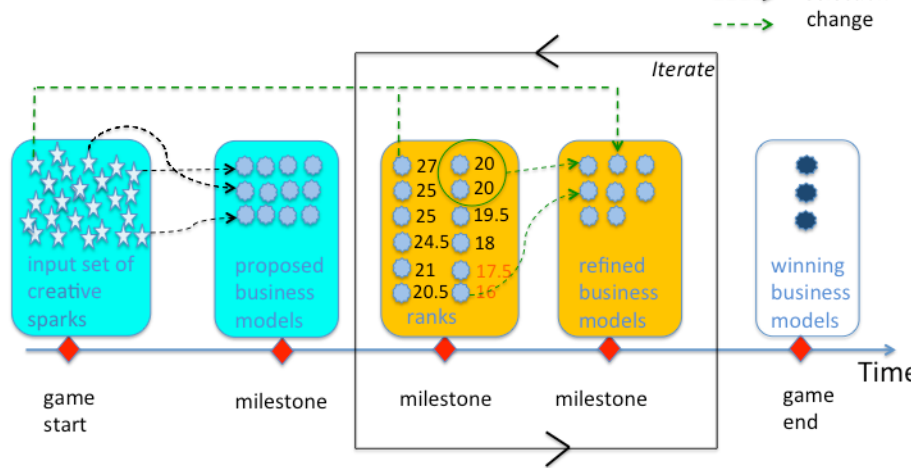
Figure 5. Gamified collaboration process. Activities performed at the individual level are in the blue boxes, whereas the iterated activities of evaluation and refinement of business models, performed collaboratively, are in the orange